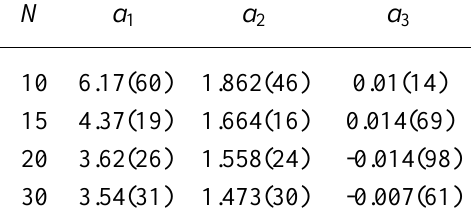
Table 3: Estimates for the JK parameters for polyalanine.